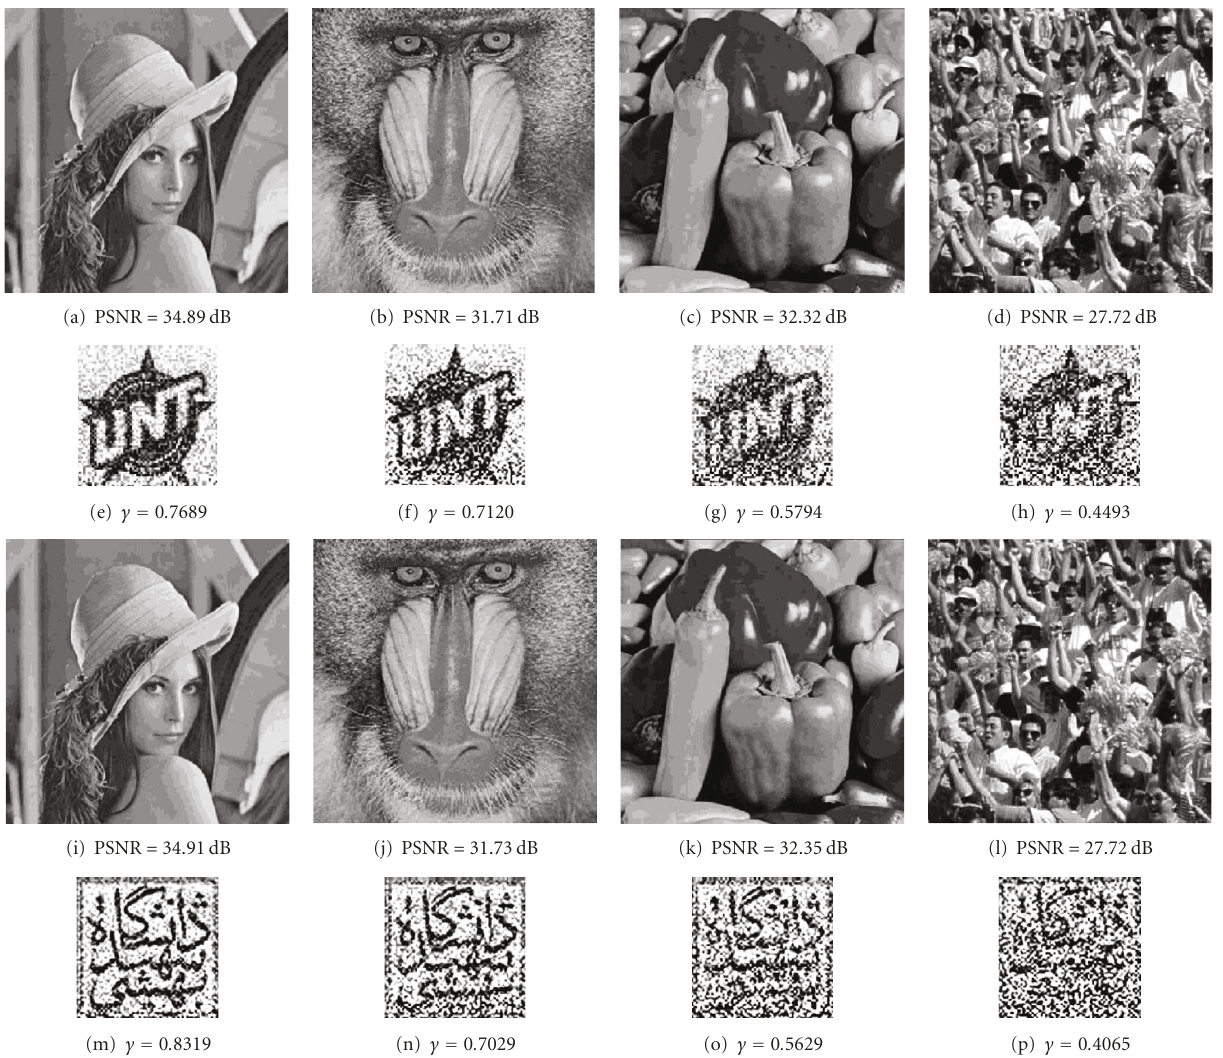
Figure 14: (a)–(d) The watermarked Lena, Baboon, Peppers and Crowd images with 256 × 256 watermark image as shown in Figure 11(b) after JPEG compression with quality factor 40%, 30%, 20% and 10%, respectively. (e)–(h) The extracted watermarks (256 × 256) from (a)–(d), respectively. (i)–(l) The watermarked Lena, Baboon, Peppers and Crowd images with 256 × 256 watermark image as shown in Figure 11(d) after JPEG compression with quality factor 40%, 30%, 20% and 10%, respectively. (m)–(p) The extracted watermarks (256 × 256) from (i)–(l),